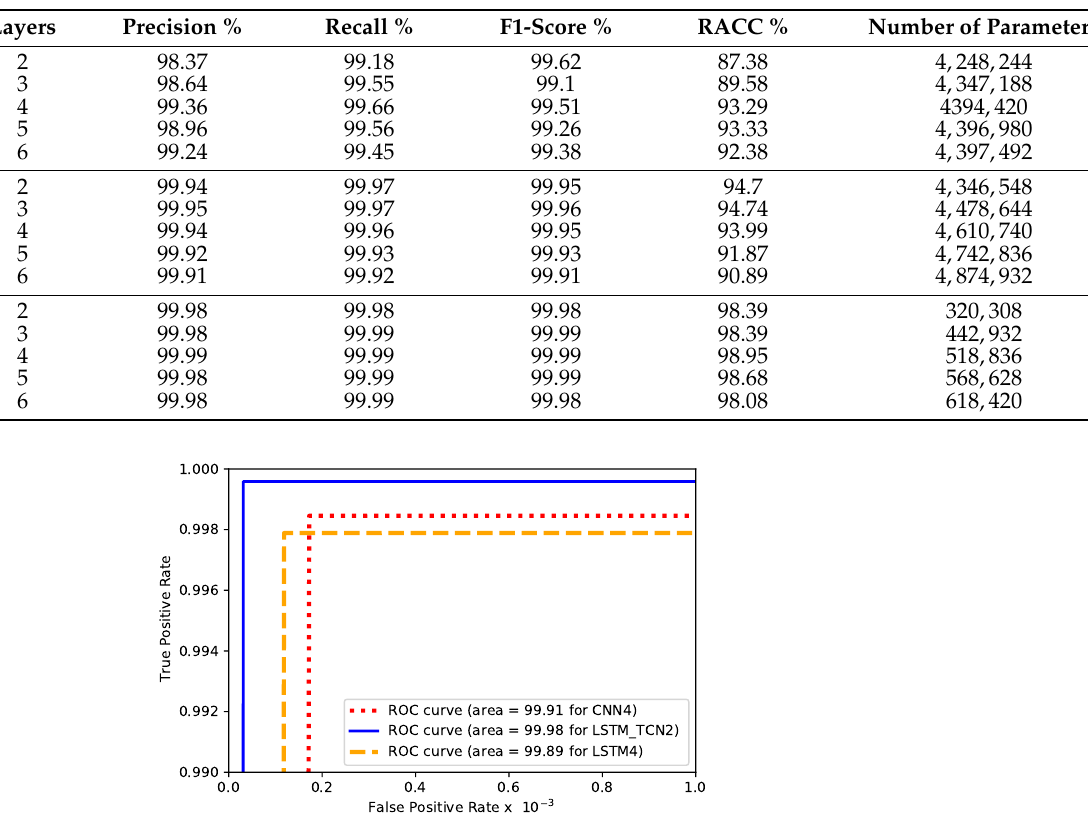
Figure 4. ROC curves for the proposed mechanism, CNN, and LSTM in IEEE 118-bus system under L 2 -norm =